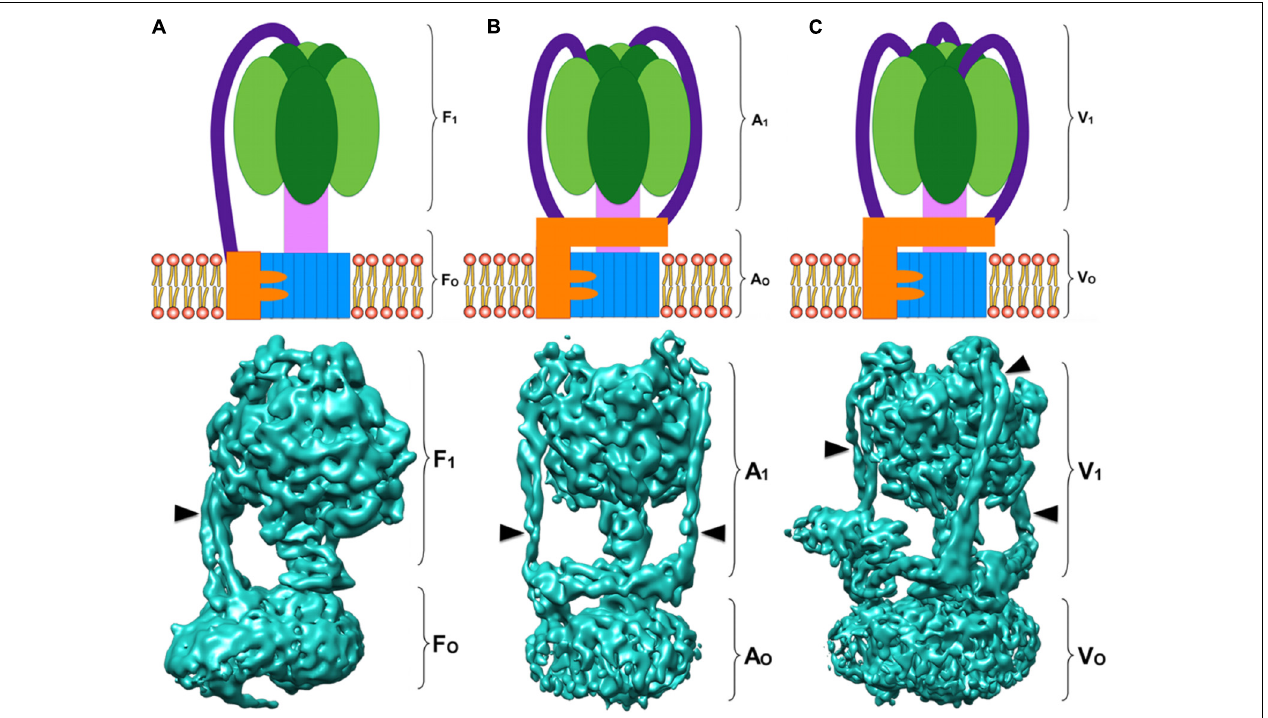
FIGURE 1 | Rotary ATPases. (A) Schematic representation of an F-ATPase (Top) and three dimensional structure of the bovine heart mitochondria F-ATPase (Bottom) (Zhou et al., 2015) EMD 3164. (B) Schematic representation of an A-ATPase (Top) and three dimensional structure of the Thermus thermophilus A-ATPase (Bottom) (Schep et al., 2016) EMD 5335. (C) Schematic representation of a V-ATPase (Top) and three dimensional structure of the Saccharomyces cerevisiae V-ATPase (Bottom) (Zhao et al., 2015) EMD 6285. All the three dimensional maps were generated from electron cryo-microscopy images. The colors in the schematizations represent: catalytic core in dark and light green, central rotor in light pink, c -ring oligomer in blue, subunit a in orange, and peripheral stalks in dark purple. The arrowheads point to the peripheral